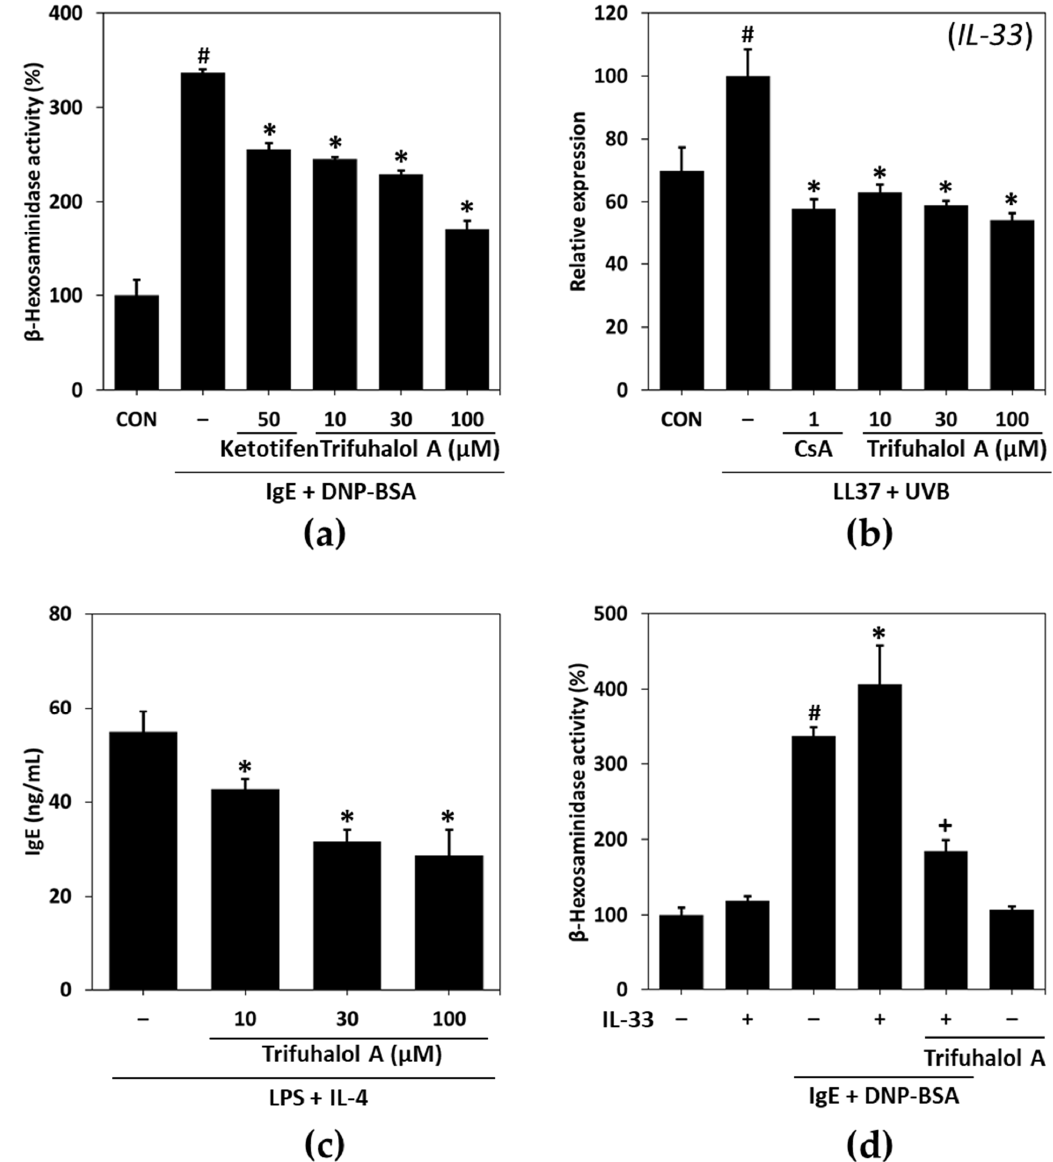
Figure 1. Effects of trifuhalol A on allergic inflammation-related mediators. ( a ) RBL-2H3 cells were sensitized with anti-DNP IgE (100 ng/mL) and treated with the indicated concentrations of trifuhalol A and DNP-BSA (1 μ g/mL). The β -hexosaminidase release was calculated relative to the control (CON). Each bar represents the mean ± S.D. of the duplicates. # p < 0.05 vs. the control group; * p < 0.05 vs. the anti-DNP IgE + DNP-BSA-treated group. ( b ) Representative data of qPCR analysis of IL-33 mRNA normalized to β -actin in LL37 (2 µ M) + UVB (15 mJ/cm 2 )-treated HaCaT cells. HaCaT cells were treated with trifuhalol A in combination with LL37/UVB for 24 h to measure IL-33 expression. Each bar represents the mean ± SD of two experiments. # p < 0.05 vs. control; * p < 0.05 vs. LL37/UVB-treated group. CsA; 1 µ M cyclosporine A. ( c ) U266B1 cells were stimulated with LPS (4 µ g/mL) + IL-4 (5 ng/mL) in the presence or absence of trifuhalol A for 72 h, and IgE levels in the culture supernatants were measured using ELISA. Each bar represents the mean ± S.D. of two experiments. * p < 0.05 vs. the LPS + IL-4-treated group. ( d ) RBL-2H3 cells were sensitized with anti-DNP IgE (50 ng/mL) and IL-33 (70 pg/mL) and treated with trifuhalol A (100 uM) and DNP-BSA (3 ng/mL). The β -hexosaminidase release was calculated relative to the control (CON). Each bar represents the mean ± S.D. of the duplicates. # p < 0.05 vs. the control group; * p < 0.05 vs. the anti-DNP-BSA-treated group; + p < 0.05 vs. the anti-DNP-BSA-IL-33-treated